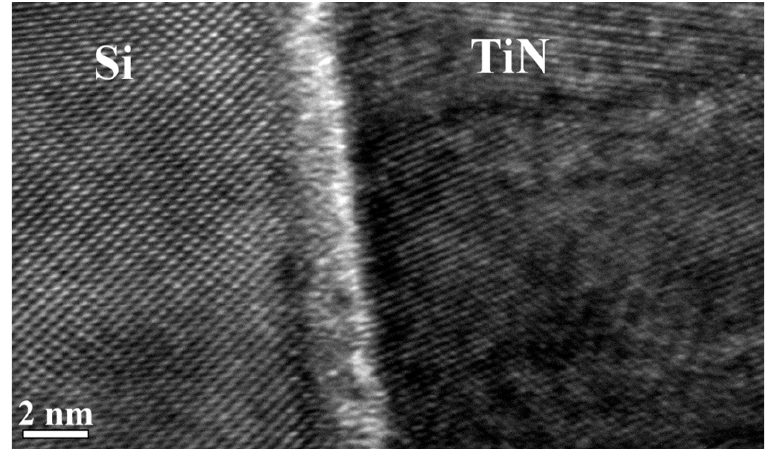
Figure 2. High-resolution TEM image of a Si (110) cross-section, showing (100) planes in the TiN film and (111) planes Si substrate, with the interface between them oriented parallel to the electron beam.